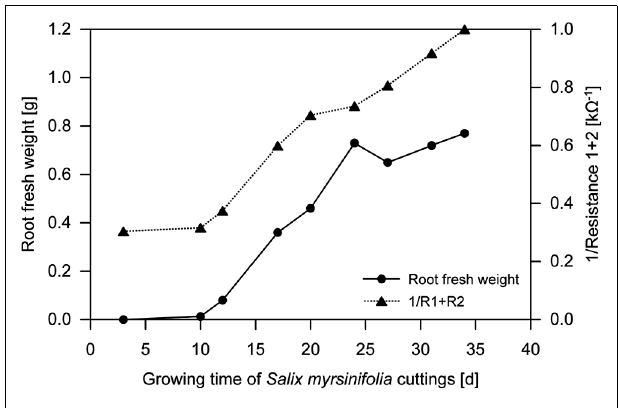
FIGURE 4 | Fresh weight of hydroponically grown Salix spp. roots and the reciprocal sum of resistances R 1 and R 2 during growth (mean, n = 3; Repo etal., 2005, modified). Electrochemical impedance spectroscopy (EIS) was used to determine R 1 and R 2 (see Repo etal., 2005 for details).